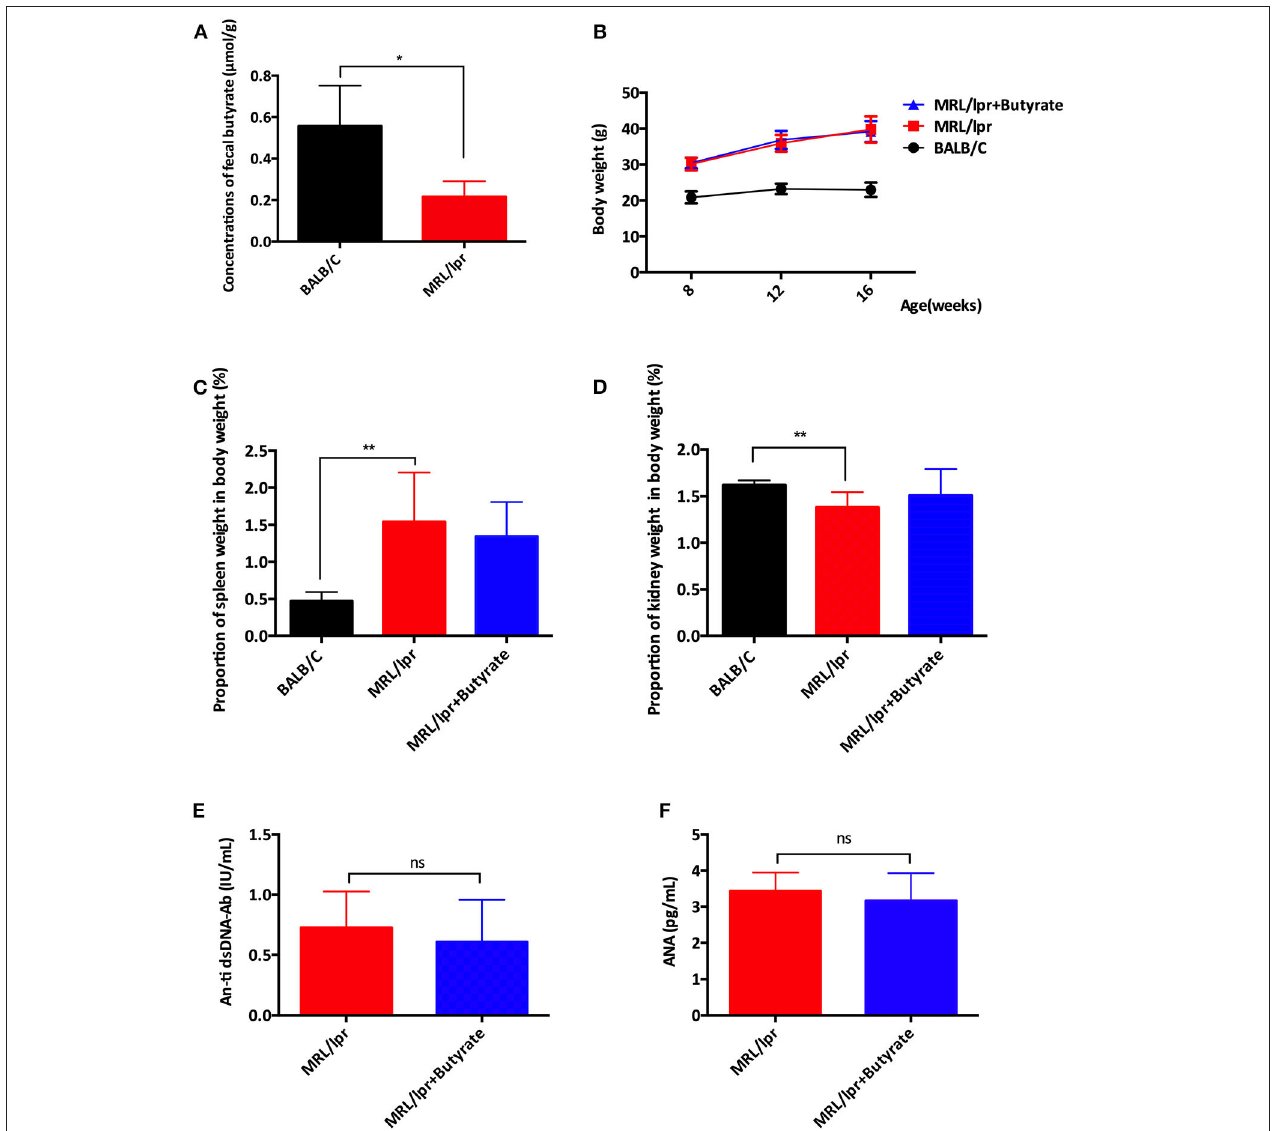
FIGURE 1 | Butyrate treatment exerted protective effects by causing disease attenuation in female MRL/lpr mice. (A) The concentrations of butyrate in stool samples of BALB/c mice and MRL/lpr mice. (B) Body weights at weeks 8, 12, and 16. (C) Spleen weight to body weight ratio (%) at 16 weeks of age (D) Kidneys weight to body weight ratio (%) at 16 weeks of age in BALB/c mice, MRL/lpr mice, and MRL/lpr mice with butyrate treatment. (E) Serum ds-DNA-Ab levels and (F) Serum ANA levels of MRL/lpr mice at 16 weeks of age; * P < 0.05, ** P < 0.01; ns, no significant